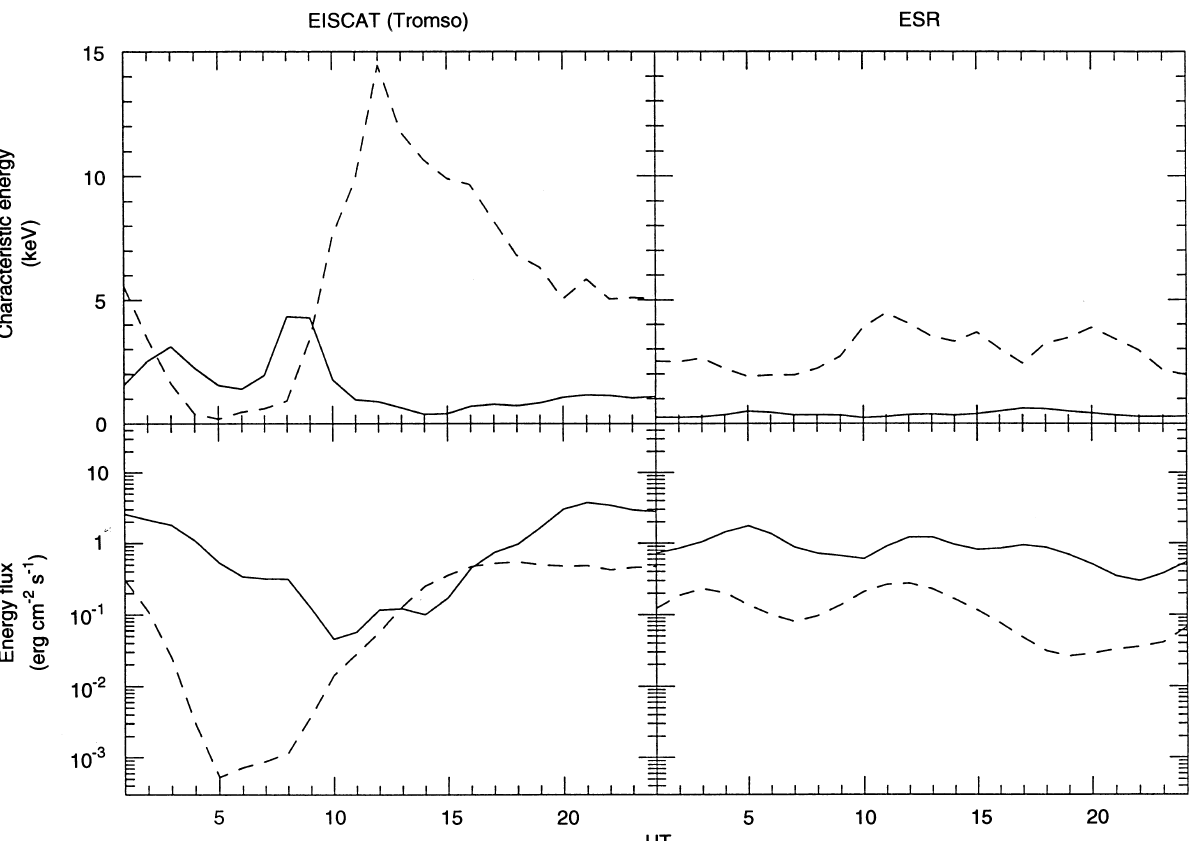
Fig. 8. The two lower panels show the integral energy flux of the electron precipitation ( solid lines ) and the ion precipitation ( dashed lines ) above EISCAT (Tromsø) ( left ) and ESR ( right ) for the same panels show the characteristic energies of these